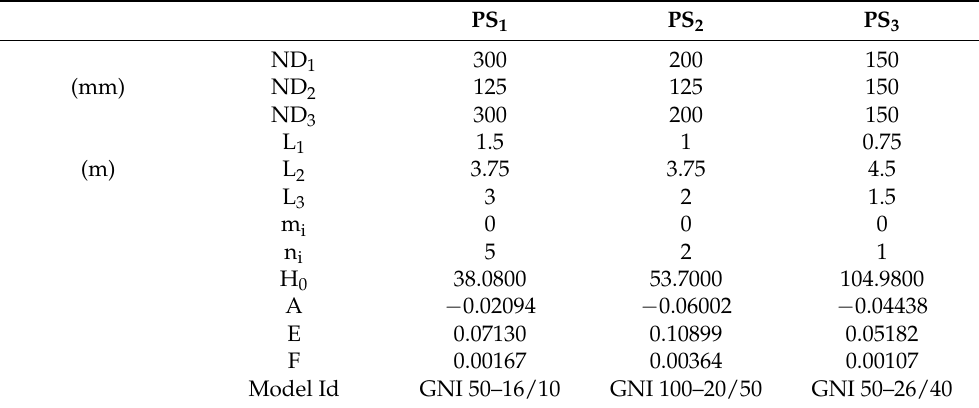
Table 5. Pump station designs for the case study.